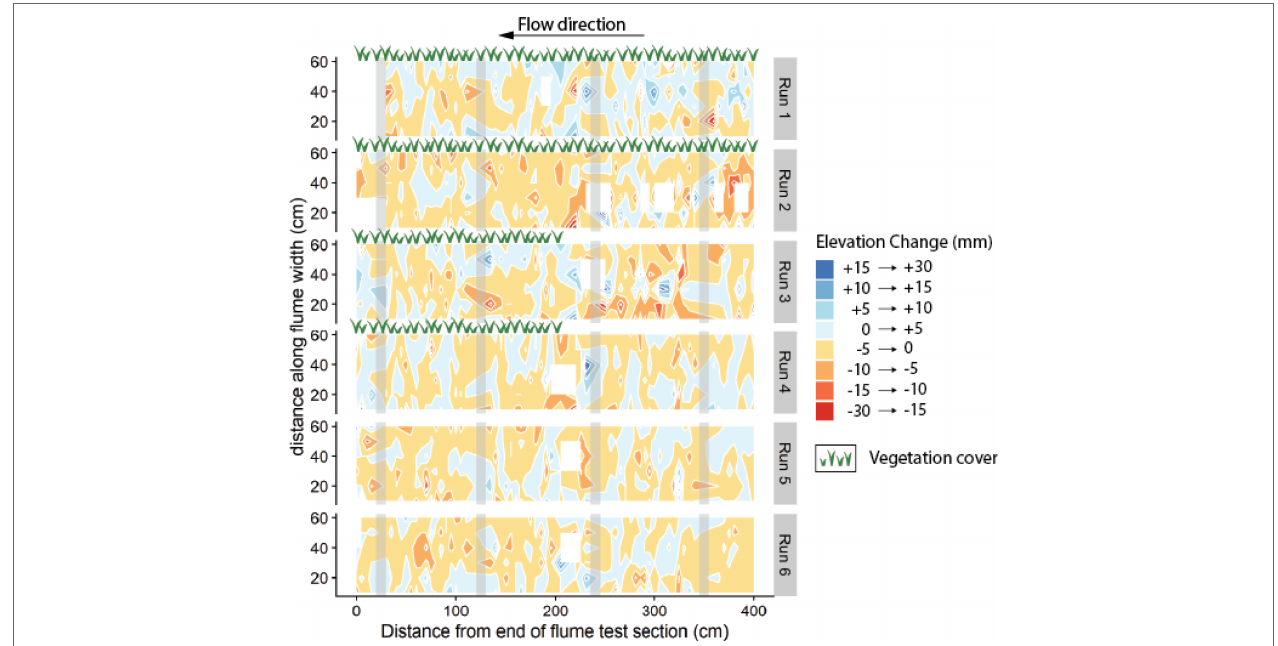
FIGURE 6 | Top view of the flume showing the spatial interpolation of the elevation changes measured during the experimental runs (Run 1 - 6). The elevation changes were calculated as the differences in surface elevation before and after each experimental run. The contours are based on a raster of 444 pin measurements (see methods). White spaces represent missing data. Gray bars represent areas where the space between the pins was 10 cm instead of 5 cm (because of obstruction of the wooden beams supporting the flume construction, see Figure 2 ).